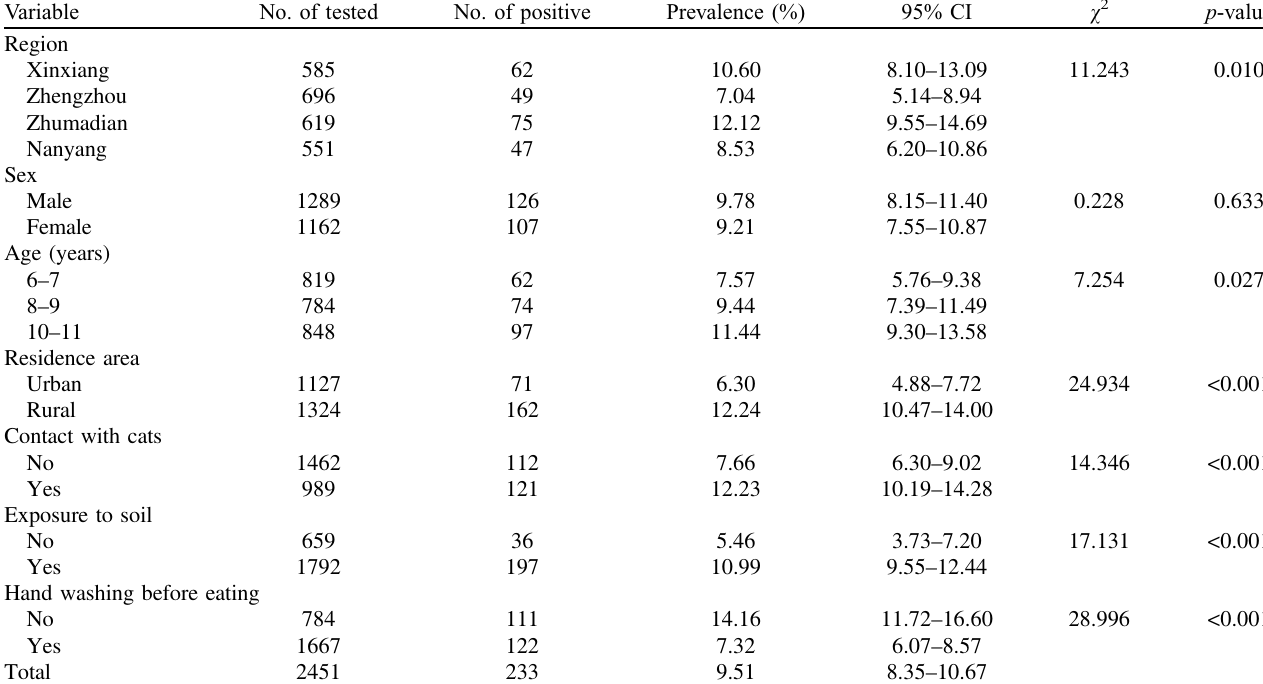
Table 3. T. gondii infection in primary school children in Henan province, central China. Variable No. of